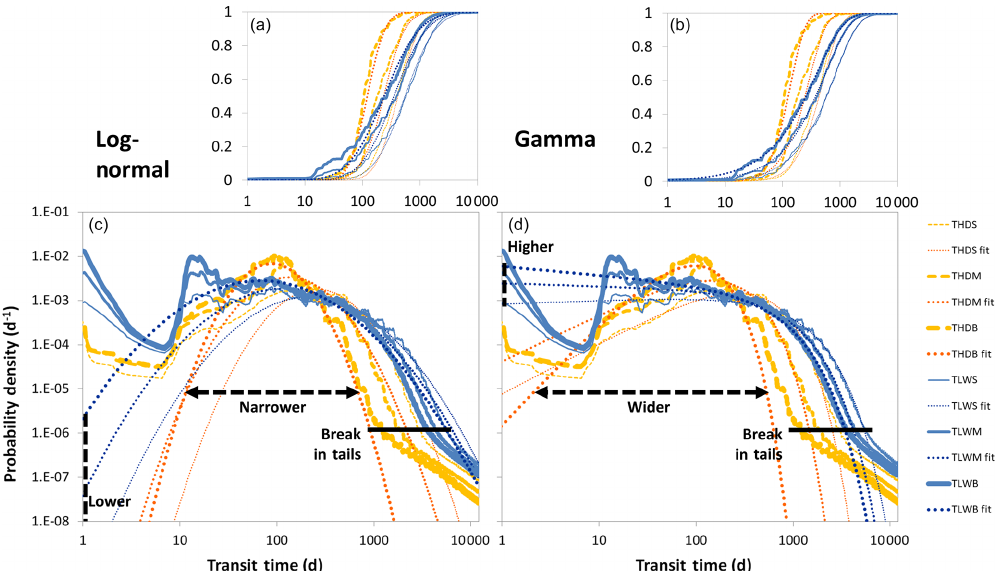
Figure 14. Modeled TTDs for low K S with high θ ant (blue) and high K S with low θ ant (yellow). Best-fit theoretical distributions (dotted lines) for the individual scenarios for the log-normal model (a, c) and the gamma model (b, d) . Breaks in the tails of the modeled TTDs are marked by the solid black lines. Small panels show cumulative